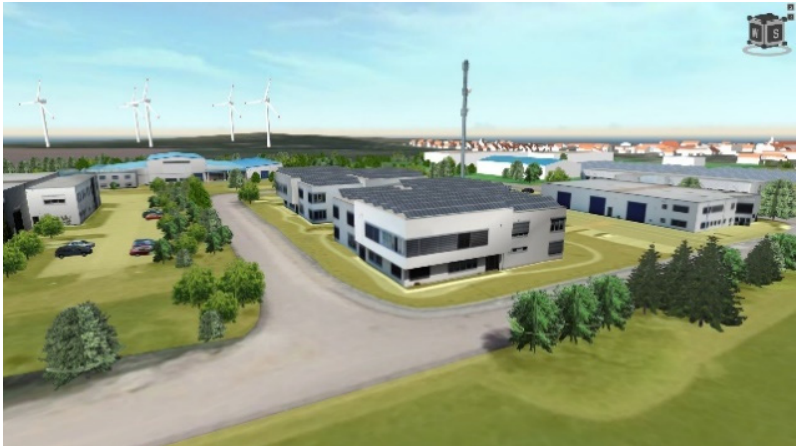
Figure 6. Virtual reality representation of the system analyzed.